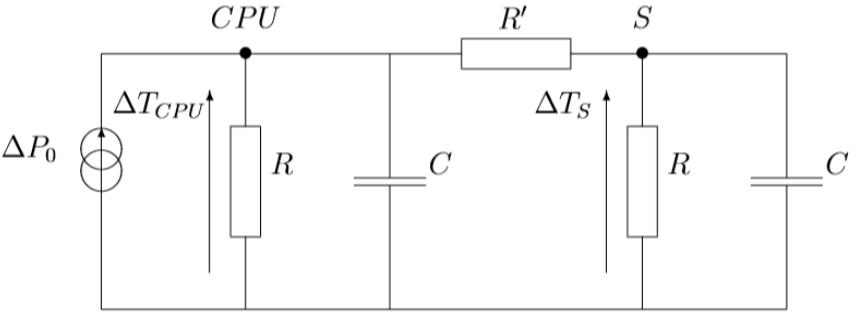
∆ T CPU and S are temperature rises above the reference (